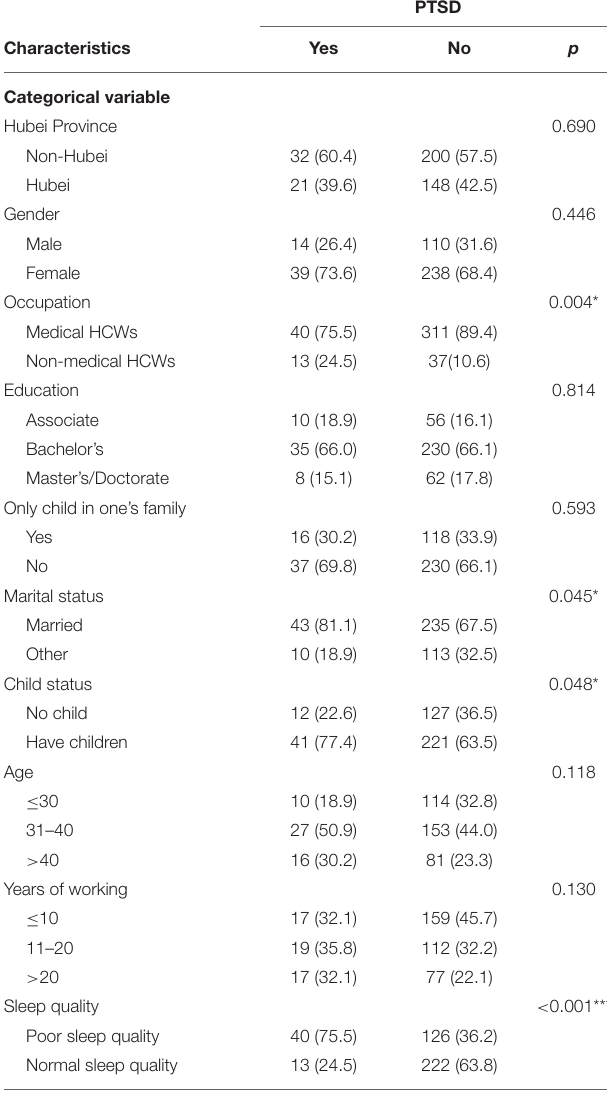
TABLE 4 | Univariate analysis of influence factors of PTSD